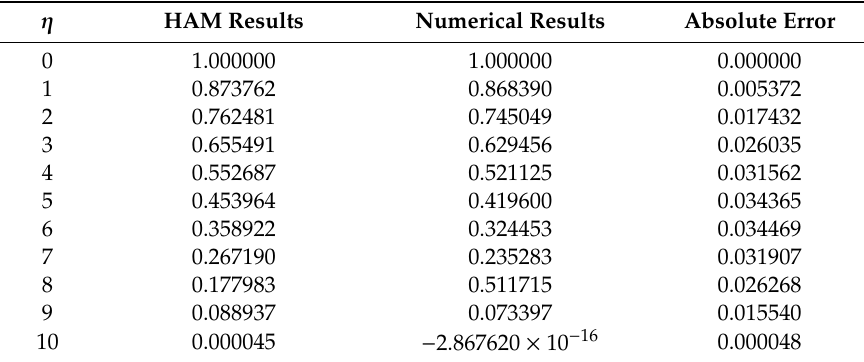
Table 3. Comparison results for sphere-shaped